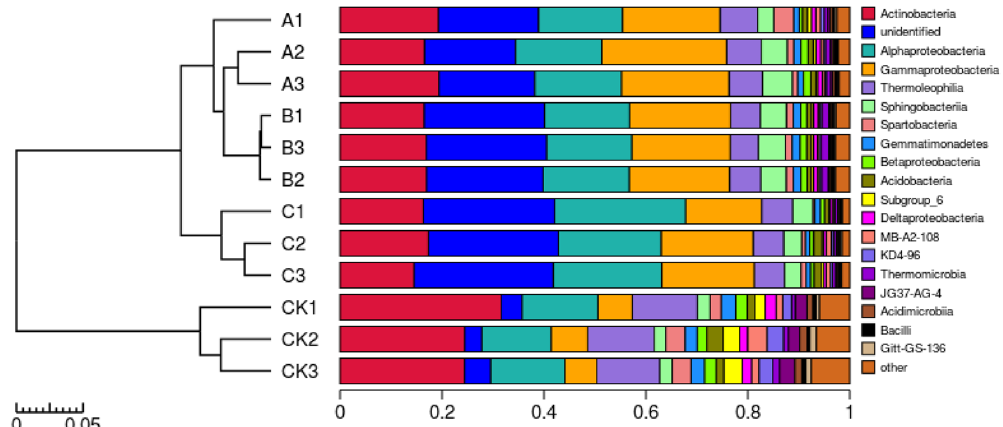
Figure 5. Analysis of relative abundance of bacterial community in ginseng soil at the class. Created using R3.6.0 software (https:// www.r- proje ct. org).